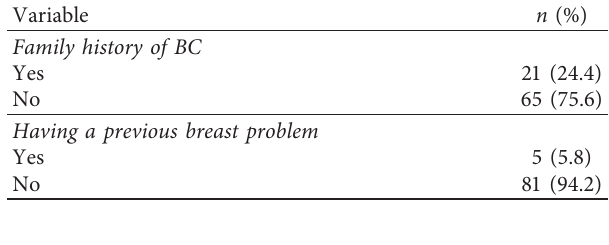
Table 1: Baseline characteristics of study participants ( n � 86). Table 2: Family and medical history.